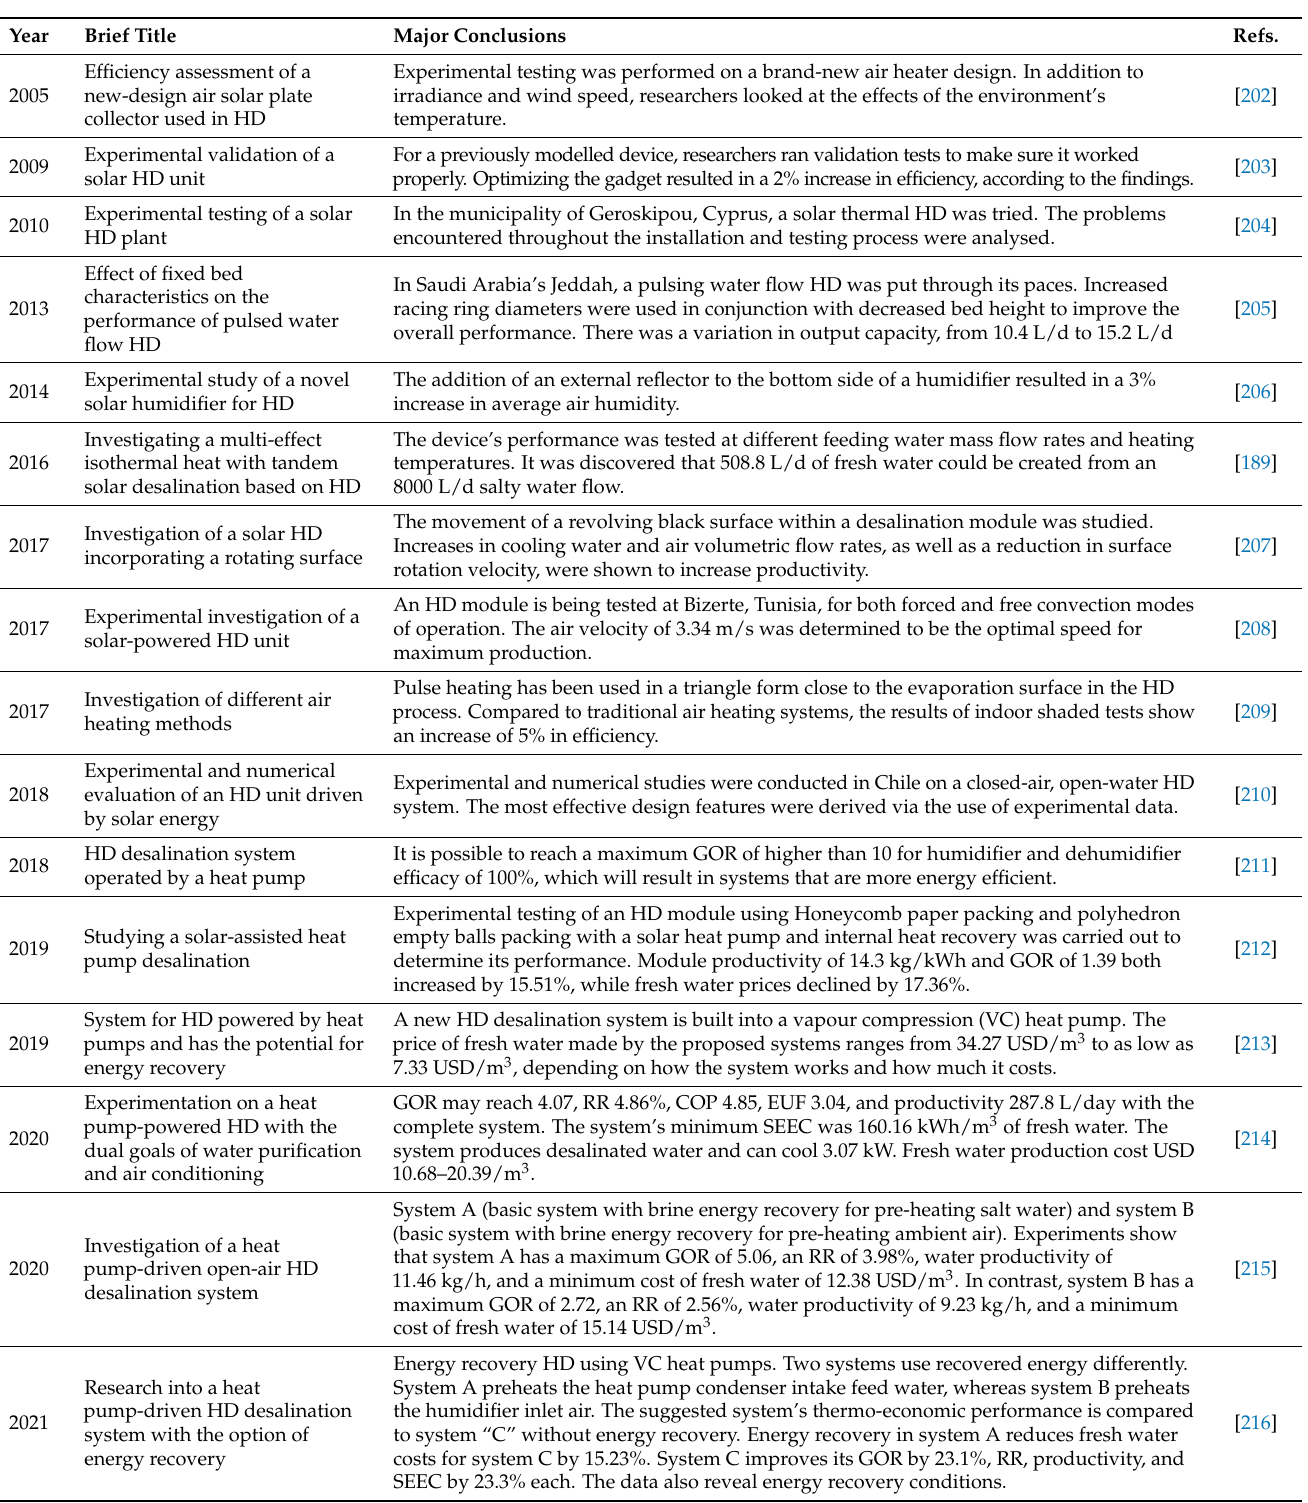
Table 5. A quick look at the research on HD plants with flat plate collectors